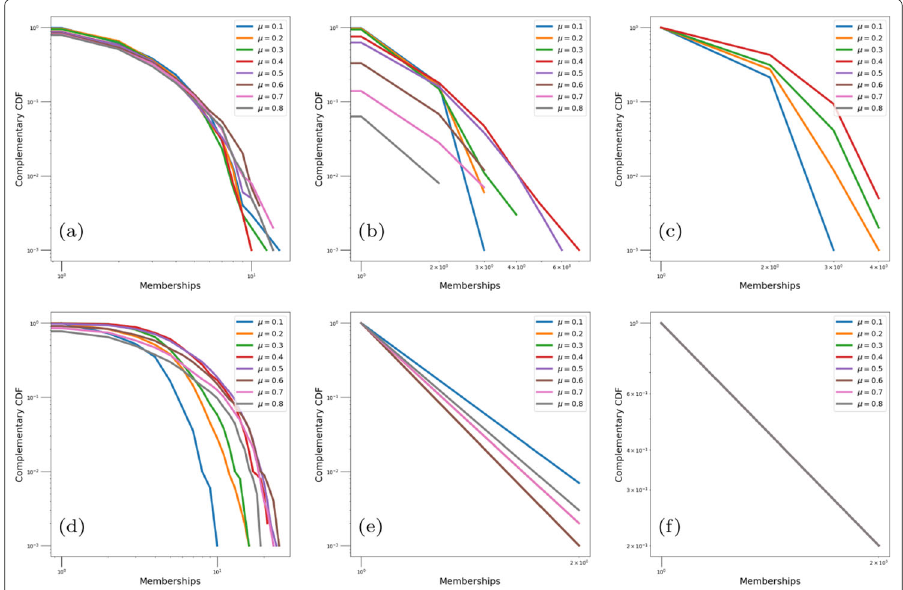
Fig. 12 Variation of the mixing parameter ( μ ) for LFR synthetic networks considering the membership of nodes: a Bigclam; b CFinder; c Copra; d Demon; e SLPA; f